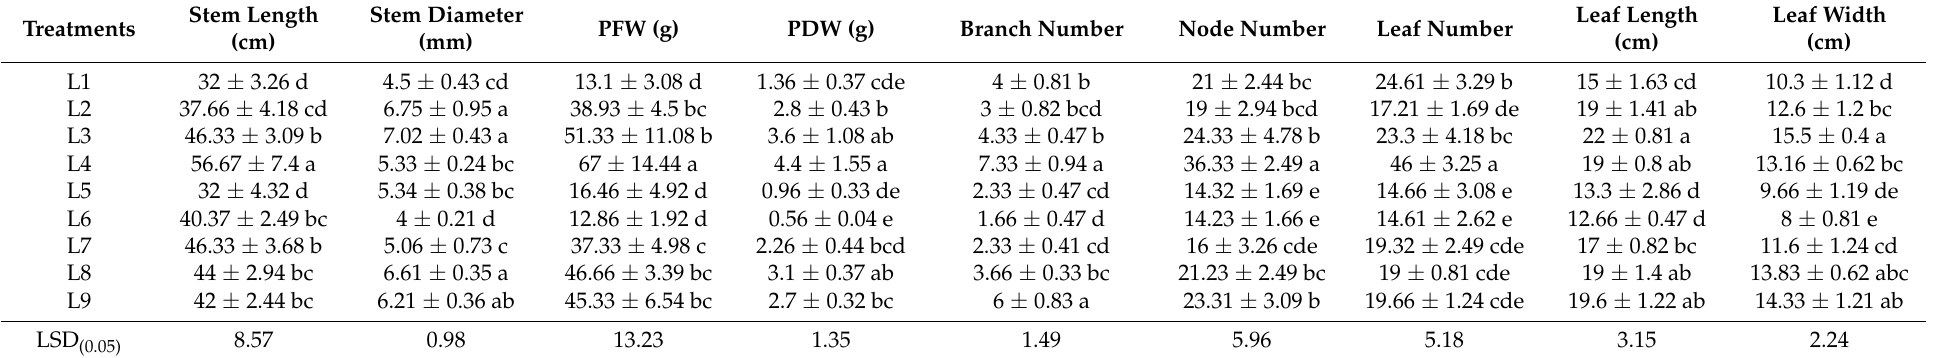
Table 3. Effect of LED lights on morphological traits of potato plants (aerial part) in the aeroponic system.